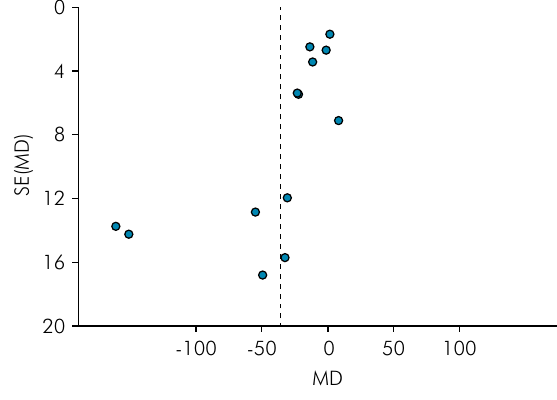
Figure 3. Funnel Plot. Heterogeneity analysis of included